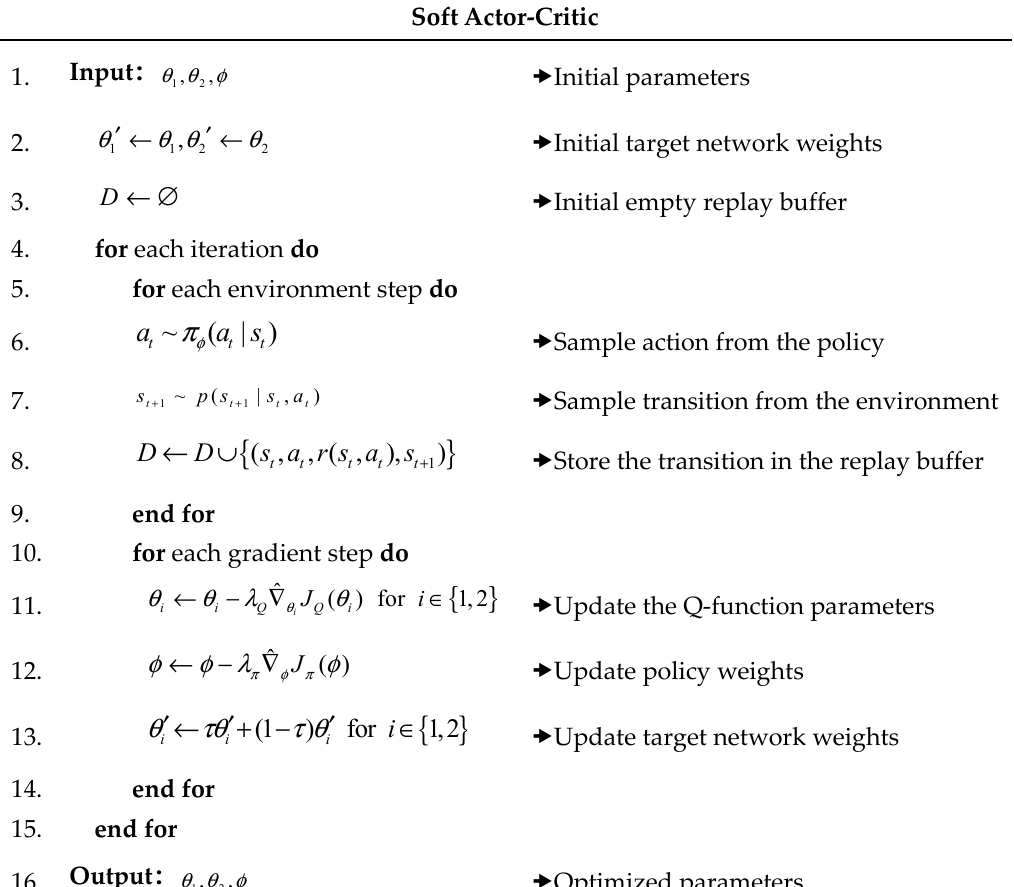
Figure 4. SAC reinforcement learning algorithm.